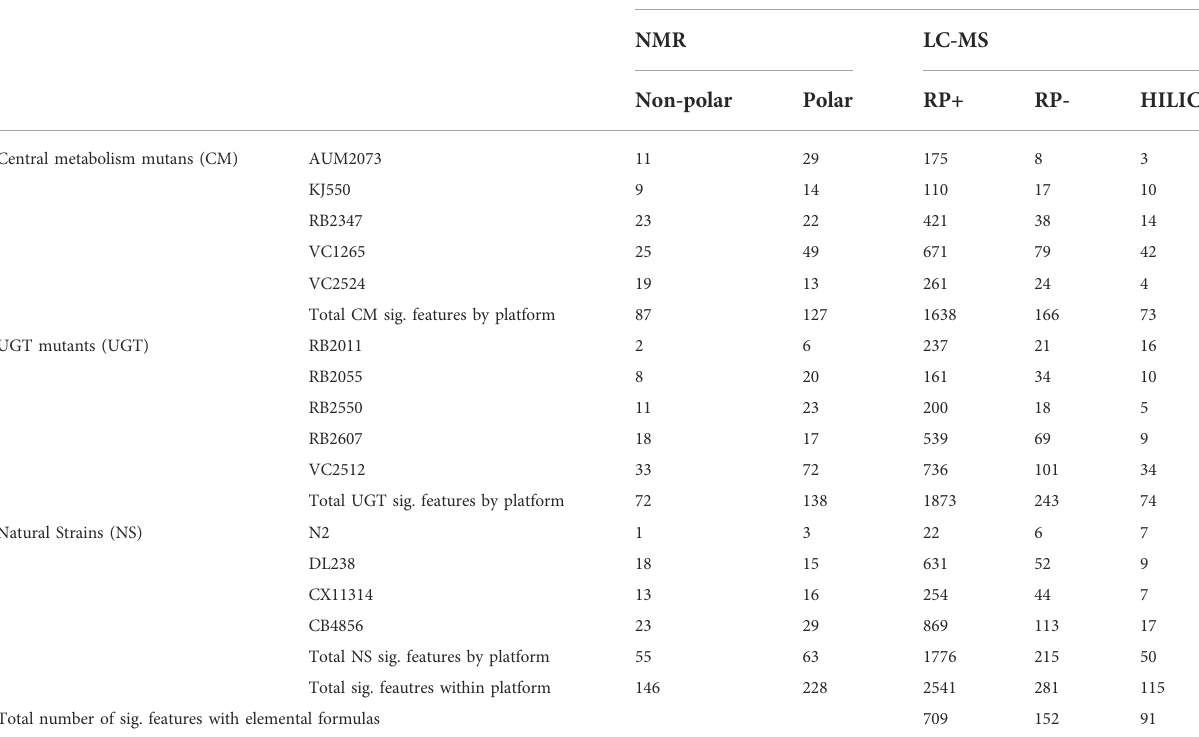
TABLE 1 Summary of signi fi cant spectral features found in all three studies across NMR and LC-MS. The total number of signi fi cant spectral features ( p < 0.05) for a given strain and each analytical platform are listed. SIRIUS (Dührkop et al., 2019) was used to determine elemental formulas for all MS/MS